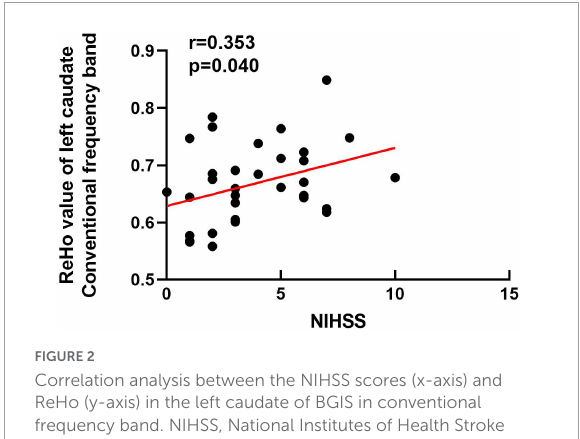
FIGURE2 Correlation analysis between the NIHSS scores (x-axis) and ReHo (y-axis) in the left caudate of BGIS in conventional frequency band. NIHSS, National Institutes of Health Stroke